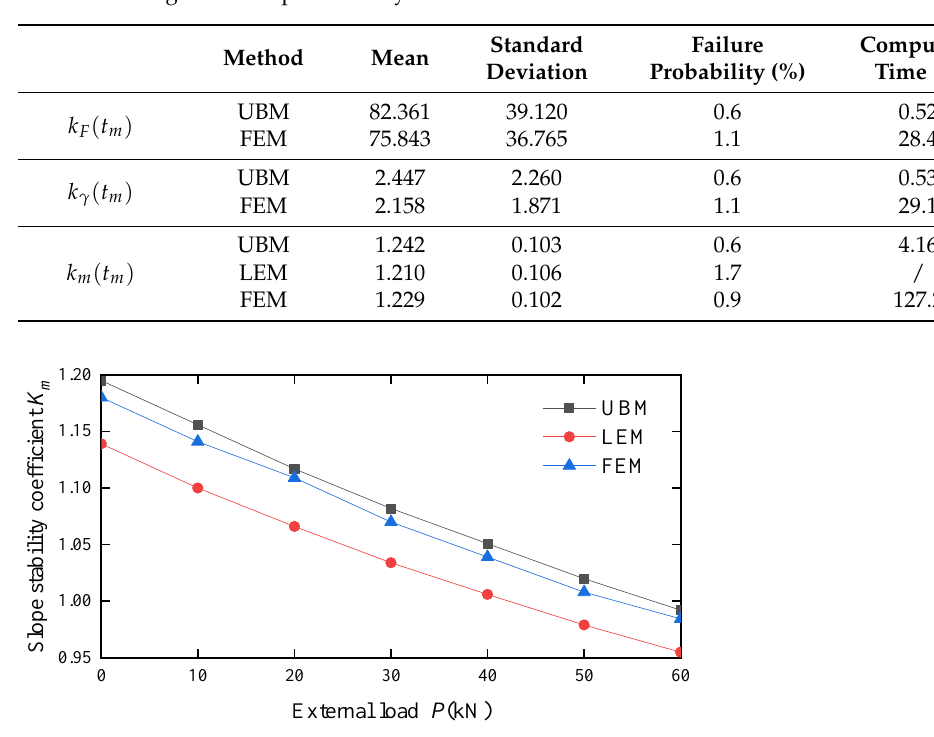
Table 2. Homogeneous slope reliability results of different methods.